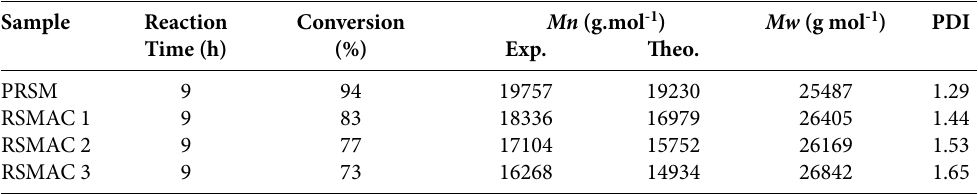
Table 2. Molecular weights and PDI values of the extracted copolymers resulted from SEC traces